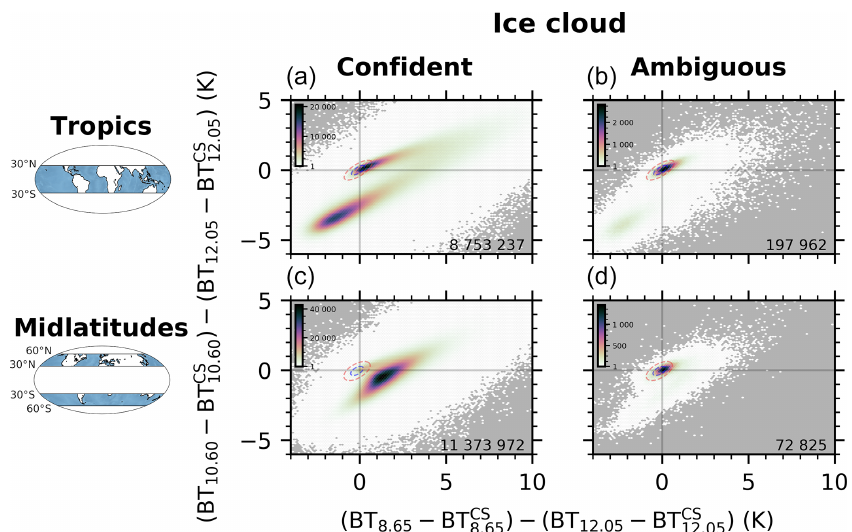
Figure 5. As Fig. 2 for ice cloud monolayer observations considered as confident (70 ≤ | CAD score , V4 | ≤ 100) (a, c) and ambiguous (0 ≤ | CAD score , V4 | < 70) (b, d) by the CALIPSO V4 algorithm. The dashed red and blue ellipses represent the observed 95% and 50% confidence intervals of IIR clear-sky observations (see Fig.